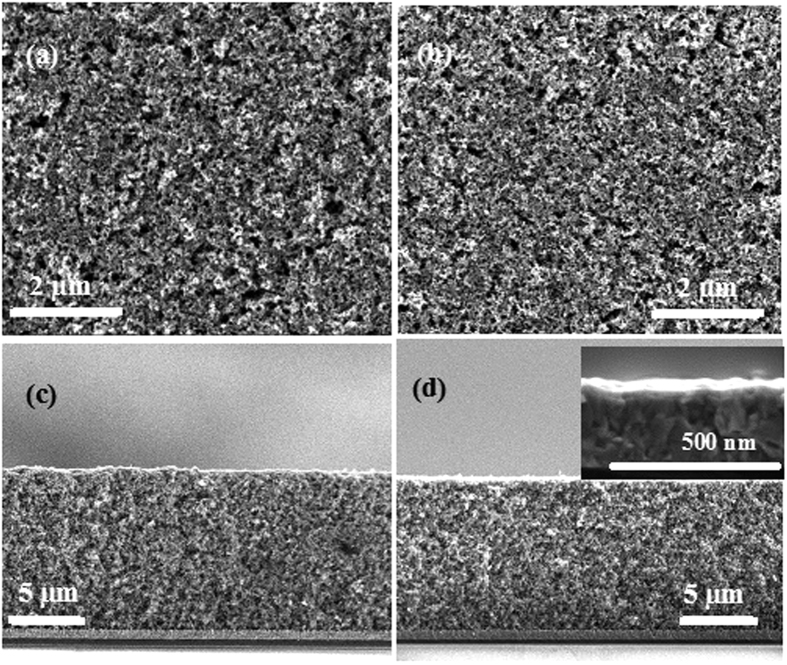
Surface and cross-section SEM images of FTO/TiO2 (a,c) and FTO/TiO2/NiO (b,d).The inserts show cross-section image of NiO coated on FTO.